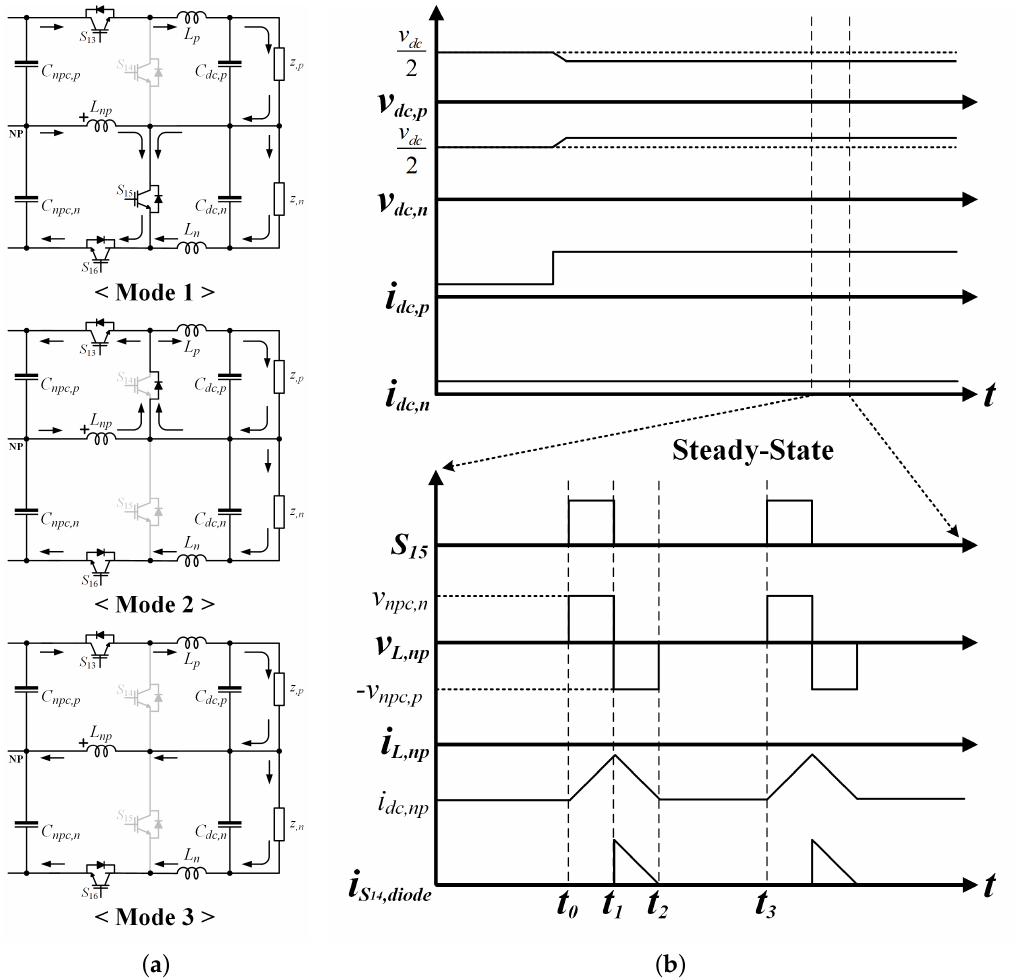
Figure 11. Balancing operation of the DC/DC converter at z p (cid:29) z n load condition: ( a ) Mode; ( b )